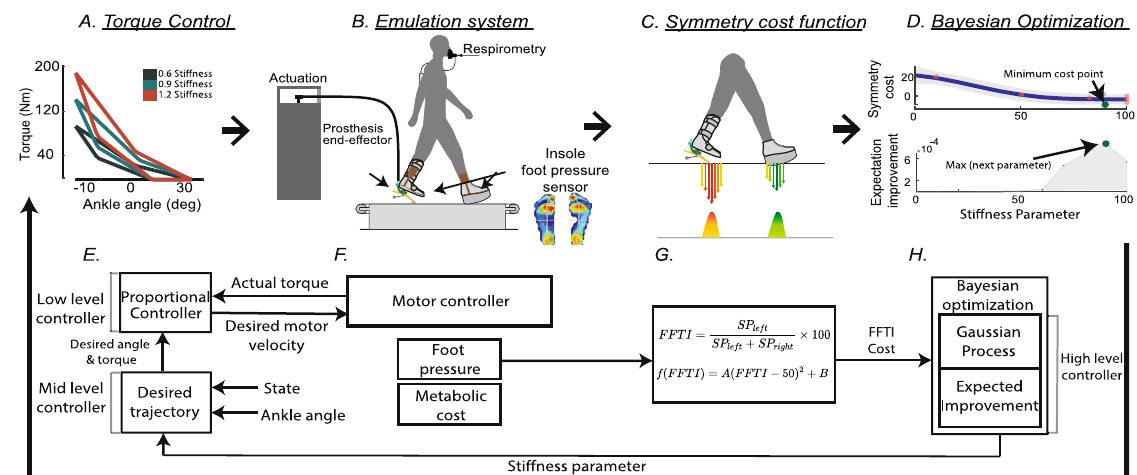
Figure 1. Overview of the human-in-the-loop optimization using the symmetry cost function. ( A ) Mid- level controller: the desired ankle torque was generated depending on ankle angle and stiffness parameter, commanded from the high-level controller. ( B ) Emulation system: the torque was delivered through the ankle- foot prosthesis emulator to a participant while collecting foot pressure and respiratory data. ( C ) Symmetric foot force-time integral (FFTI) cost function: the collected foot pressure was summed in the left ( SP left ) and right side ( SP right ) to estimate the cost of walking. ( D ) High-level controller: Bayesian optimization updated the stiffness parameter to minimize the estimated cost of walking. ( E–H ) Functional block diagram of the system: this block diagram describes how the system works in ( A–D